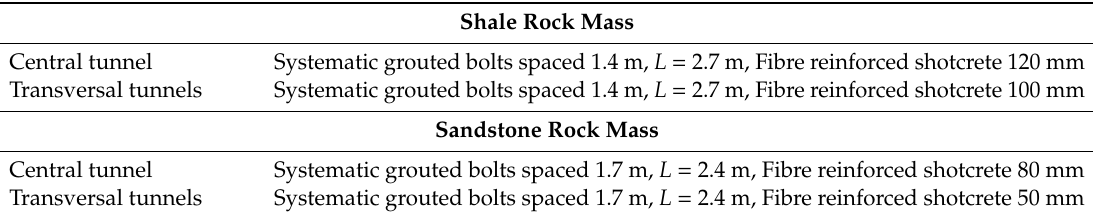
Table 5. Empirical analysis. Support categories for shale and sandstone